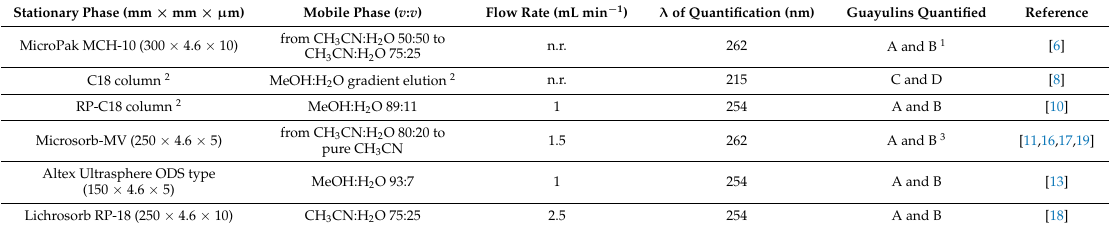
Table 1. Key features of selected literature RP-HPLC methods of analysis for guayulins in resin extracts from Guayule.